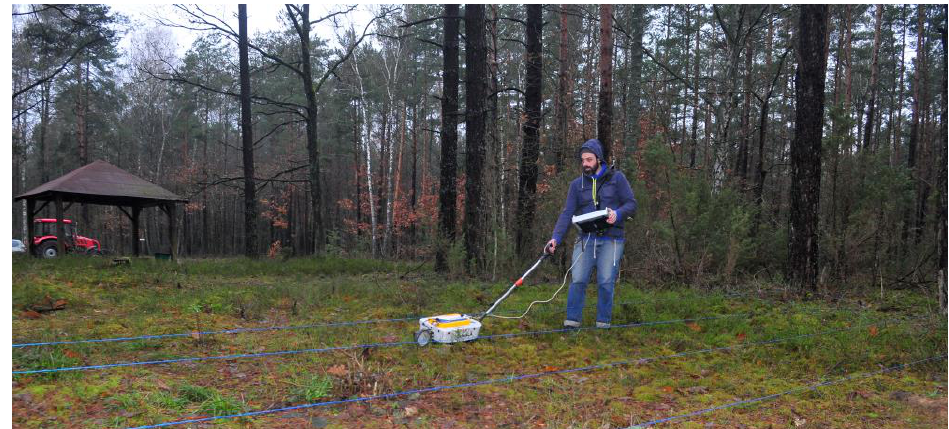
Figure 4. GPR measurements in the GPR1 area; photo: S. Różycki.